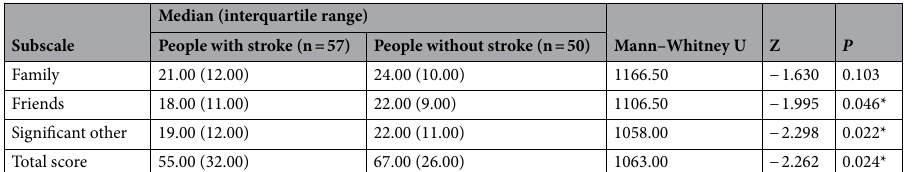
Median (interquartile range)